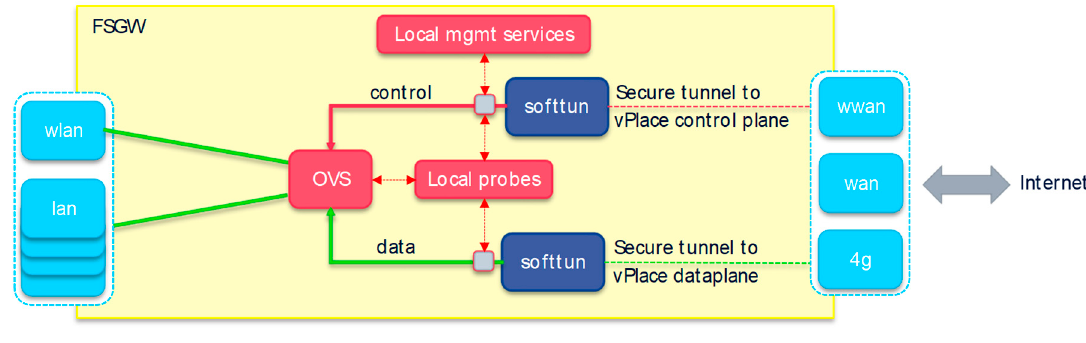
Figure 5. High-level FSGW architecture.